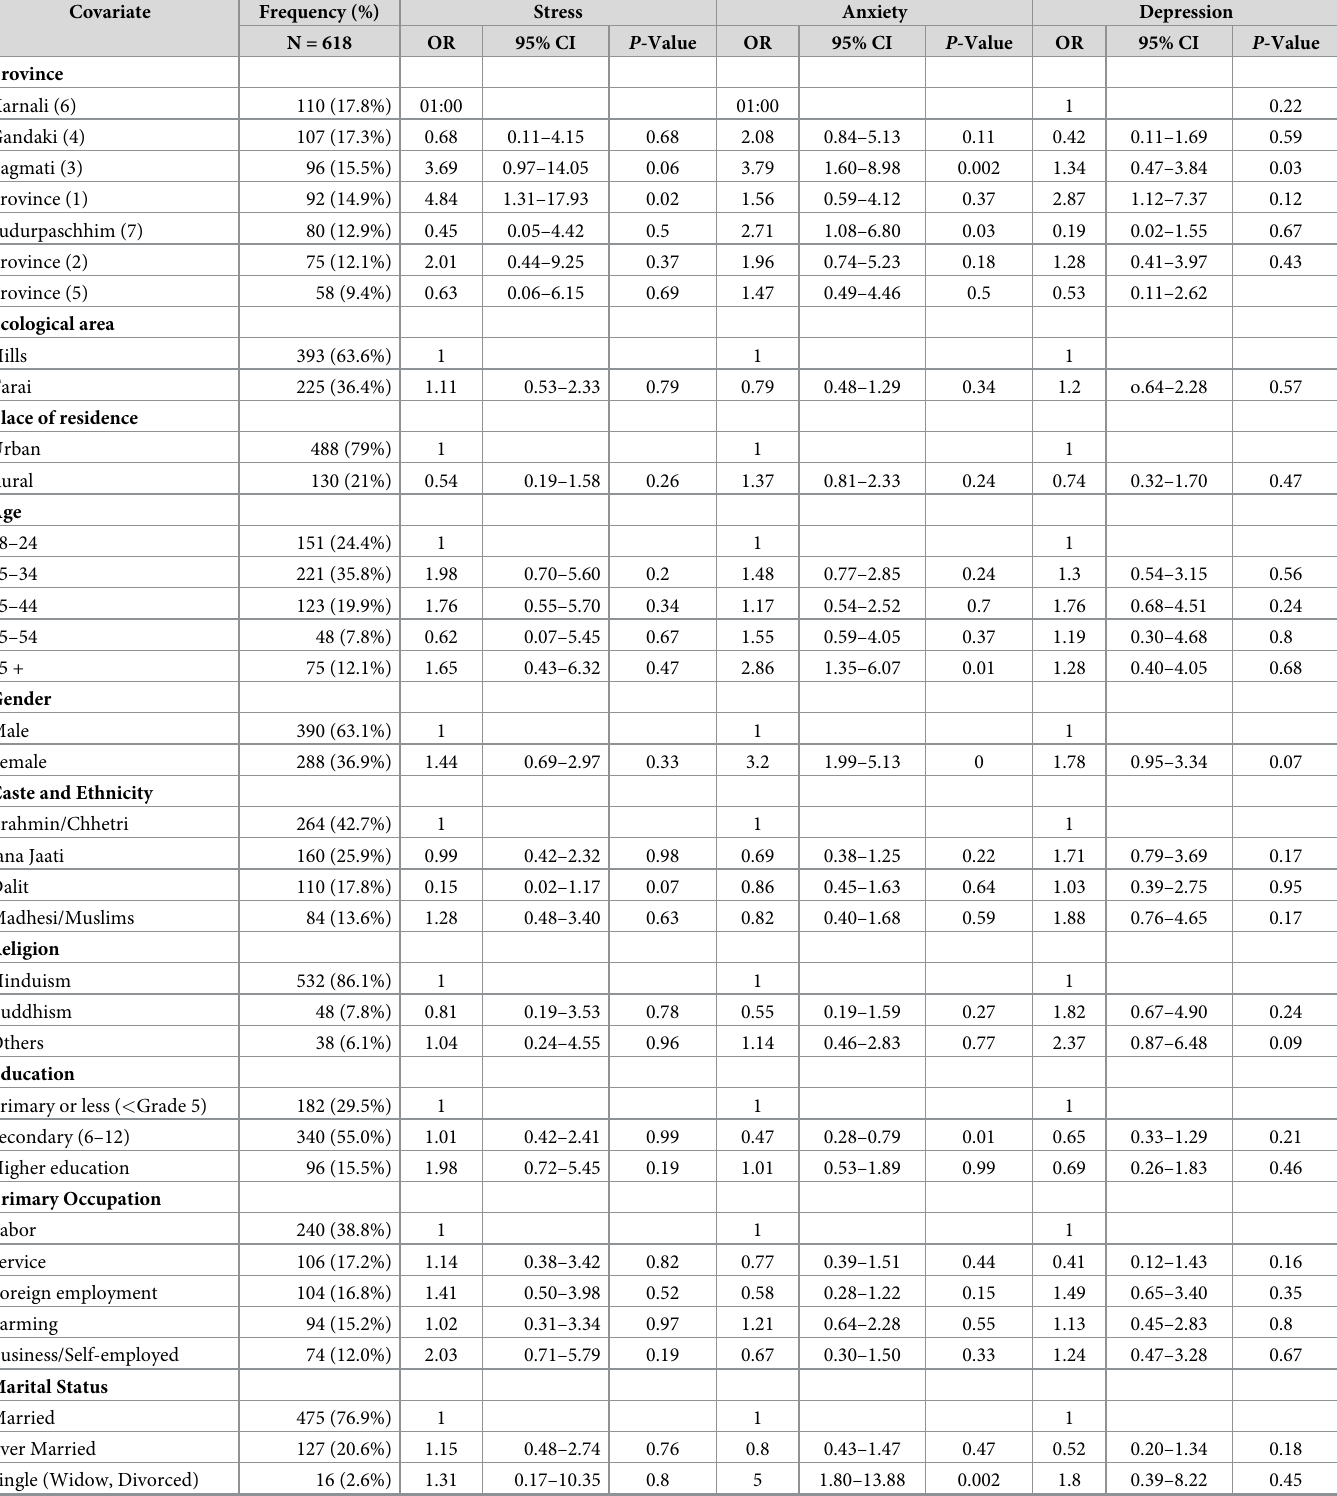
Table 4. Socio-demographic characteristics of the study participants with bivariate Odds Ratios (ORs).